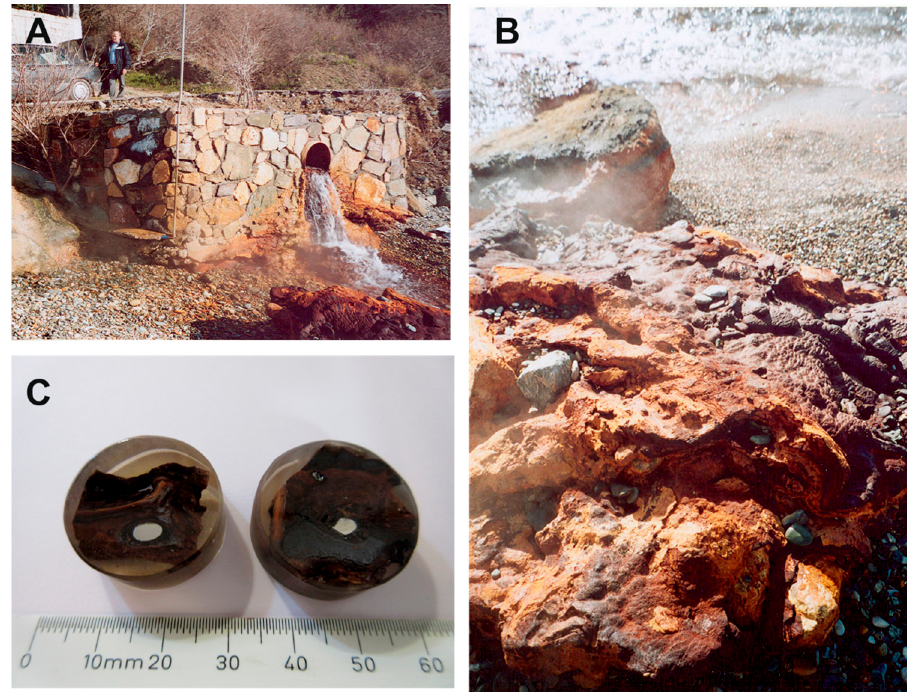
Figure 2. Iron-rich thermogenic travertines from Ilia: ( A ) Ilia hot spring. The Fe-rich thermogenic travertine deposits at the point where the pipe from the borehole vents the hot water. Local authorities remove the depositions, in order to avoid clogging of the spring; ( B ) Laminated Fe-rich travertine from Ilia; ( C ) Two polished sections including two different iron nodules and the hosting travertine.